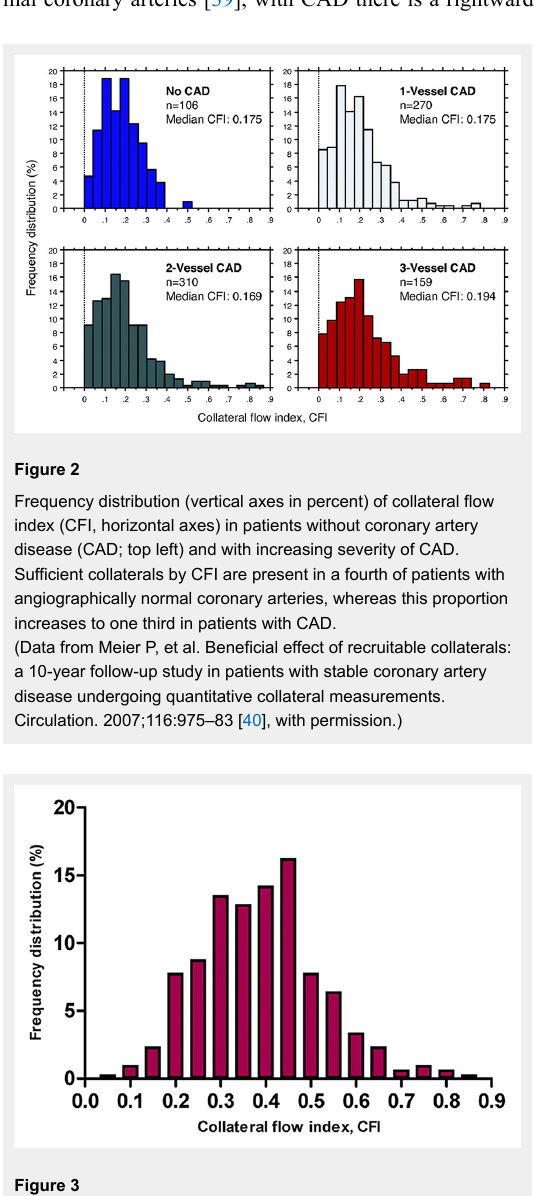
Frequency distribution (vertical axis in percent) of collateral flow index (CFI, horizontal axis) in 295 patients with chronic total occlusion. In this population mean CFI was 0.39 ± 0.14. (Adapted from van der Hoeven NW, et al. Clinical parameters associated with collateral development in patients with chronic total coronary occlusion. Heart. 2013;99:1100–5 [38], with permission from BMJ Publishing Group